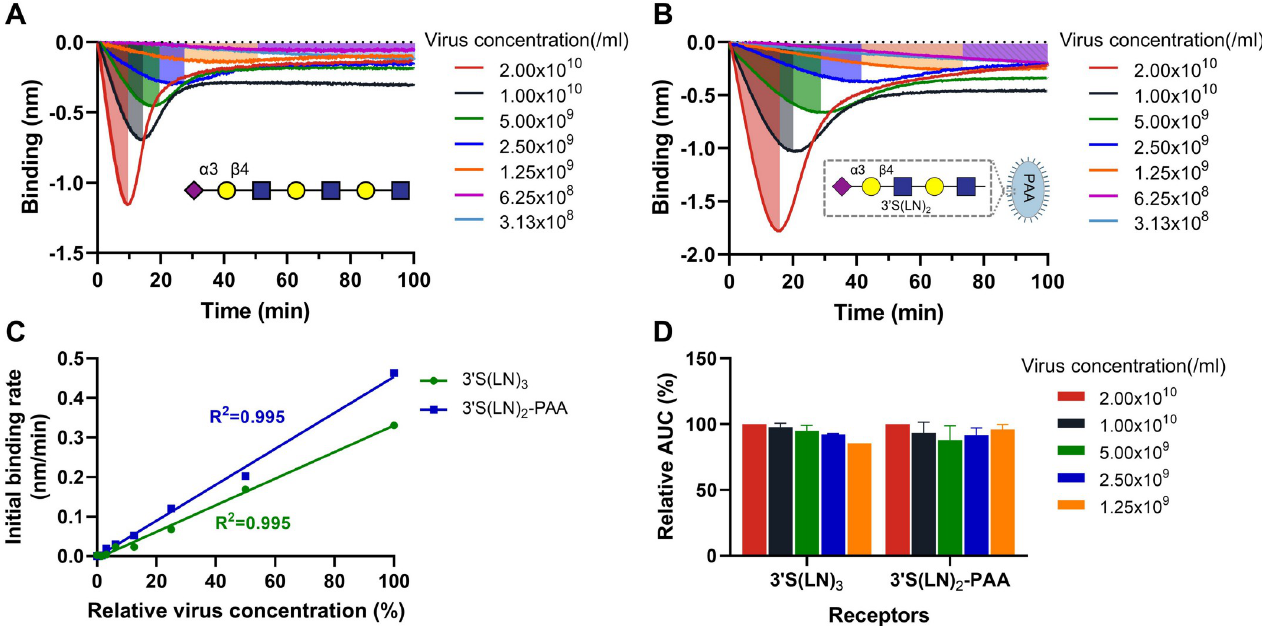
Fig 7. Virion concentration-dependent interaction with receptor-coated surfaces. Streptavidin sensors loaded to saturation with biotinylated 3’S(LN) 3 (A) or 3’S(LN) 2 -PAA (B) were incubated with SeV at different concentrations for 100 mins. (C) The observed initial binding rates (nm/min) of SeV were plotted against relative virus concentration (100% corresponds to 2.0x10 10 particles/ml) and linear regression analysis was performed. (D) The area under the curve (AUC; from start to peak) was determined at those virus concentrations that displayed peak binding values within this time frame. Means and standard deviations of two independent replicate experiments using different virus stocks are shown.